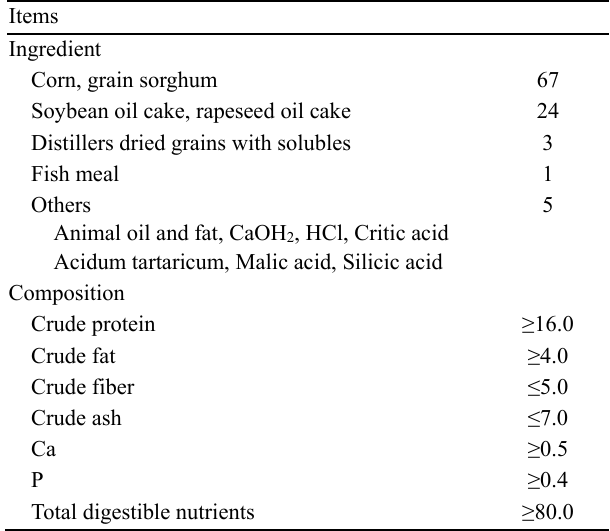
Table 1. Ingredient and composition of the diet (as-fed basis, %) Items